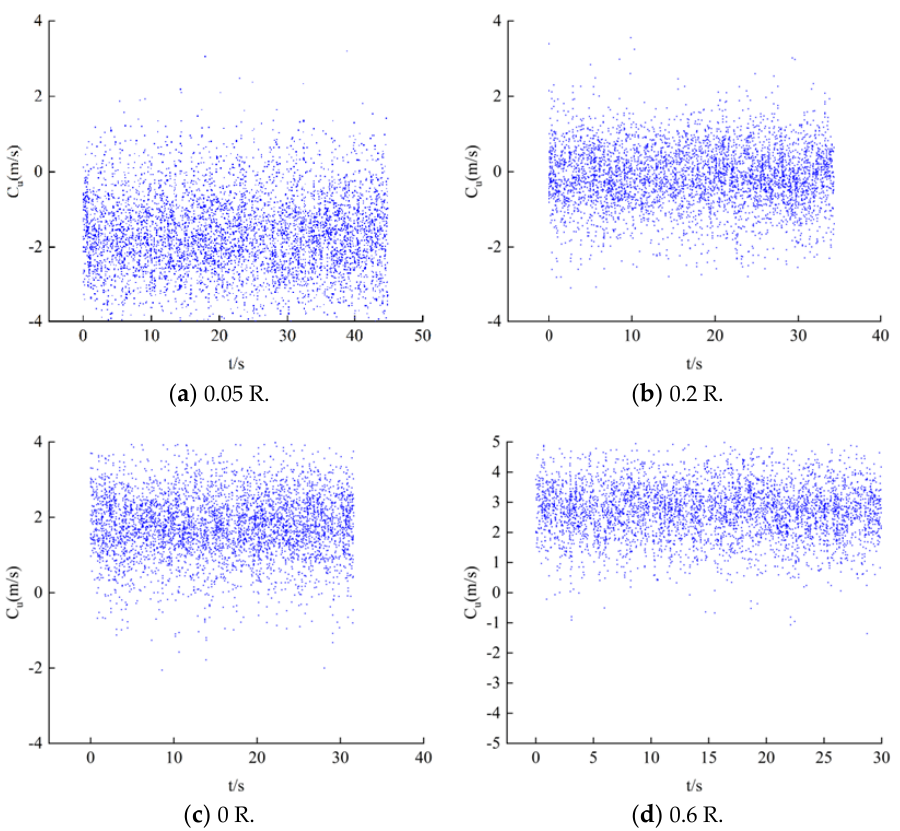
Figure 9. OP6-4 scatter plot of tangential velocity. The circumferential turbulence intensity was calculated using Equation (3). The distribution of the turbine operating condition circumferential turbulence intensity over the test radius is shown in Figure 10.